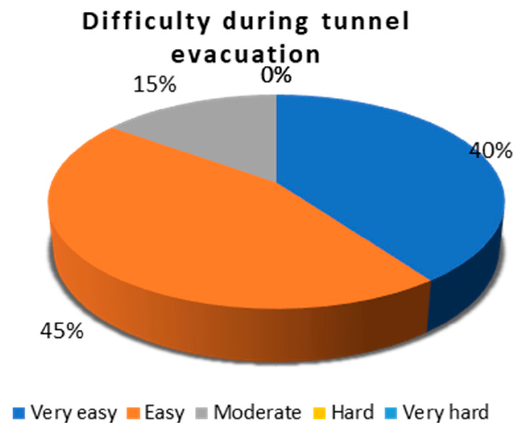
Figure 24. Difficulty during tunnel evacuation.